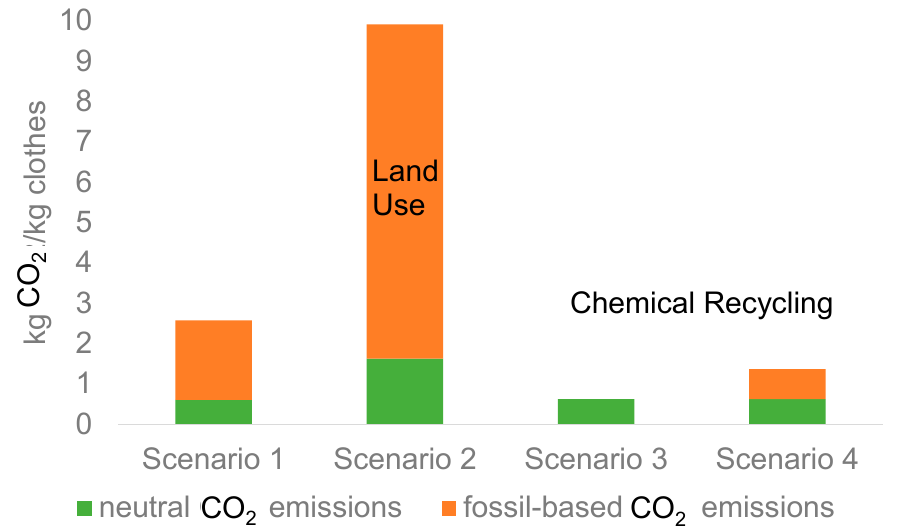
Figure 5. GHG emissions for the linear pattern versus chemical recycling.